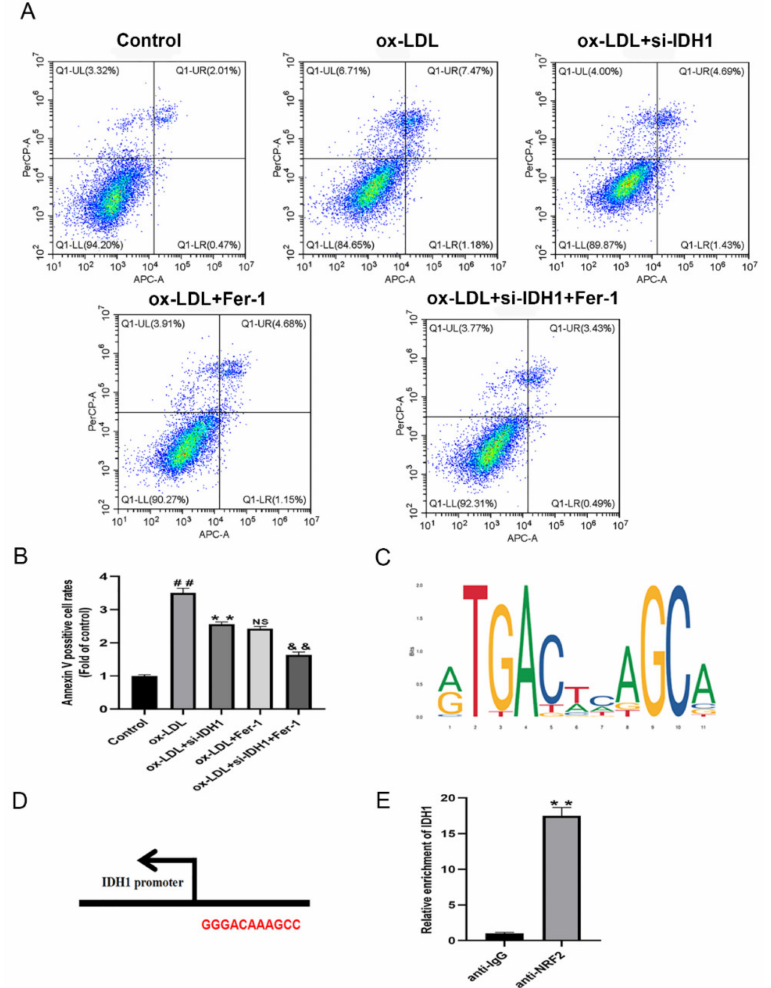
Figure 6. Inhibition of IDH1 ameliorates ox-LDL-induced macrophage apoptosis. ( A , B ) Apoptosis of RAW264.7 cells in different groups was examined via flow cytometry. ( C ) JASPAR-predicted NRF2 transcription factor binding sites. ( D ) Nrf2 and IDH1 potential binding sites. ( E ) Relative enrichment of IDH1, detected by ChIP. ## p < 0.01 vs. control group; ** p < 0.01 vs. ox-LDL-treated group; NS vs. ox-LDL and si-IDH1 treatment group. && p < 0.01 vs. ox-LDL and Fer-1 treatment group. NS, not significant. Data are presented as mean ±